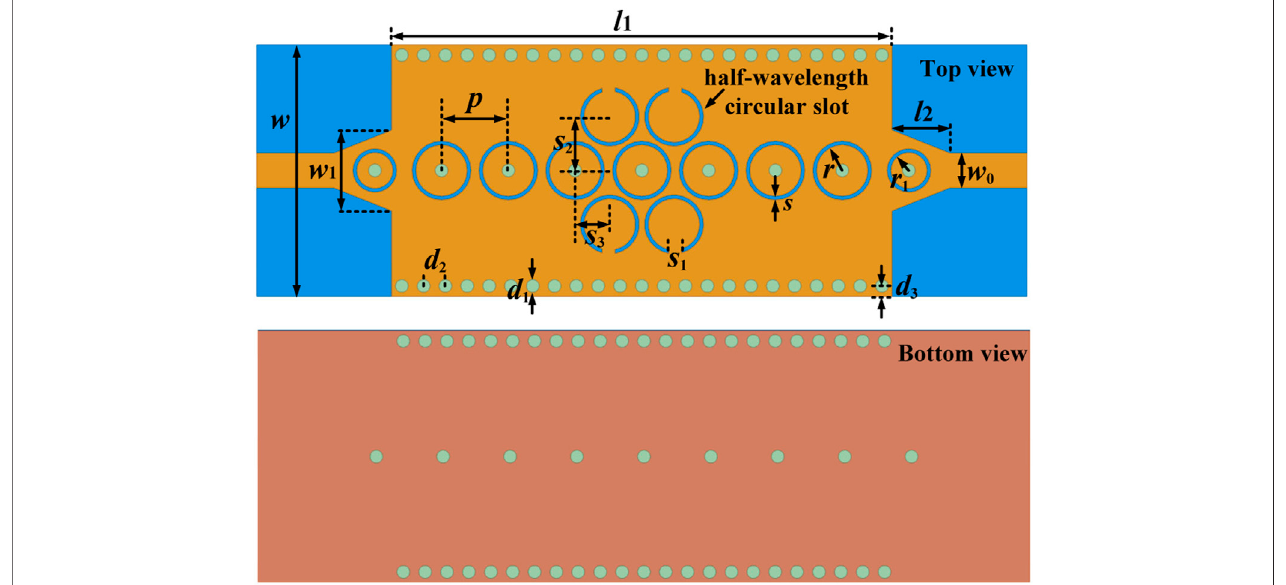
FIGURE 2 | Schematic con fi guration of the BPF with a high-selectivity notch band.